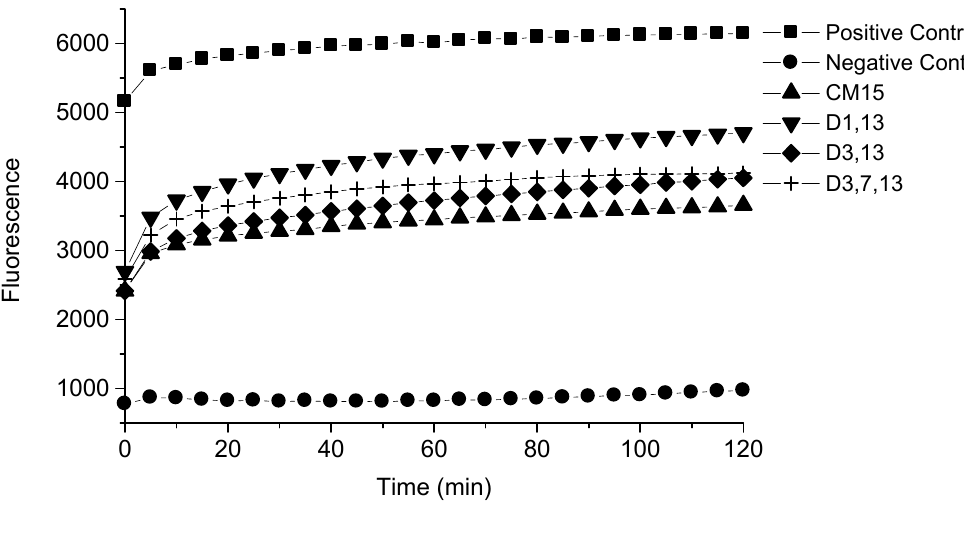
Figure 3. Peptide-induced uptake of SYTOX green by S. aureus . SYTOX green fluorescence at 530 nm as a function of time after the addition of peptide, 1% Triton X-100 (squares, positive control), or PBS (circles, negative control). Peptides were at final concentrations equal to their respective MIC values for S. aureus . Triangles, CM15 (0.5 µM); inverted triangles, D 1.13 (2 µM); diamonds, D 3,13 (4 µM); and crosses, D 3,7,13 (8